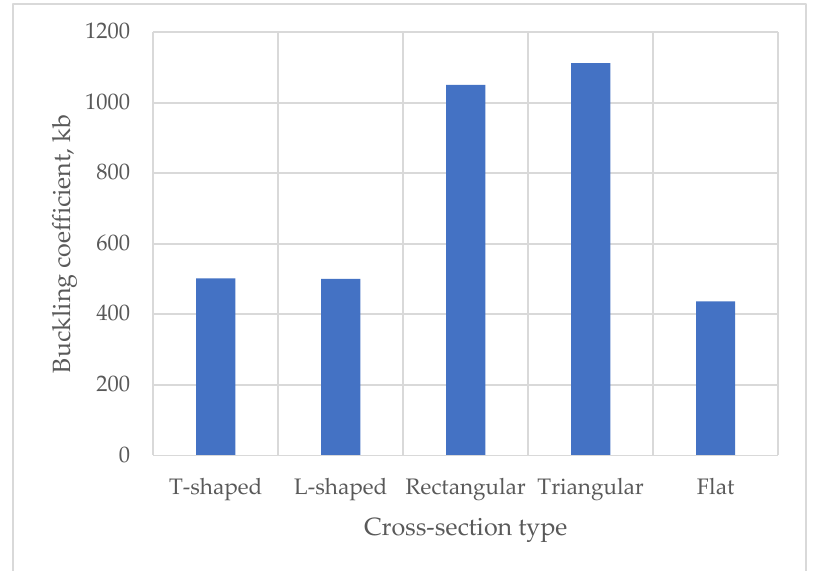
Figure 9. Comparison of buckling coefficient for two longitudinal stiffeners with various cross-section shapes ( φ = 1.0).